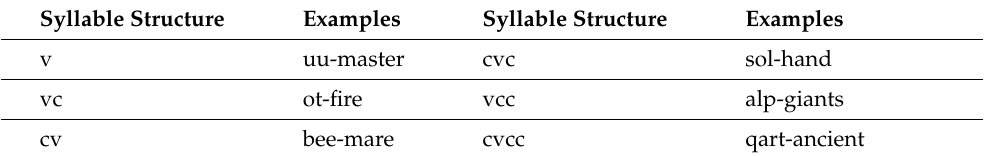
Table 7. Syllable structure of Kirghiz phonetic